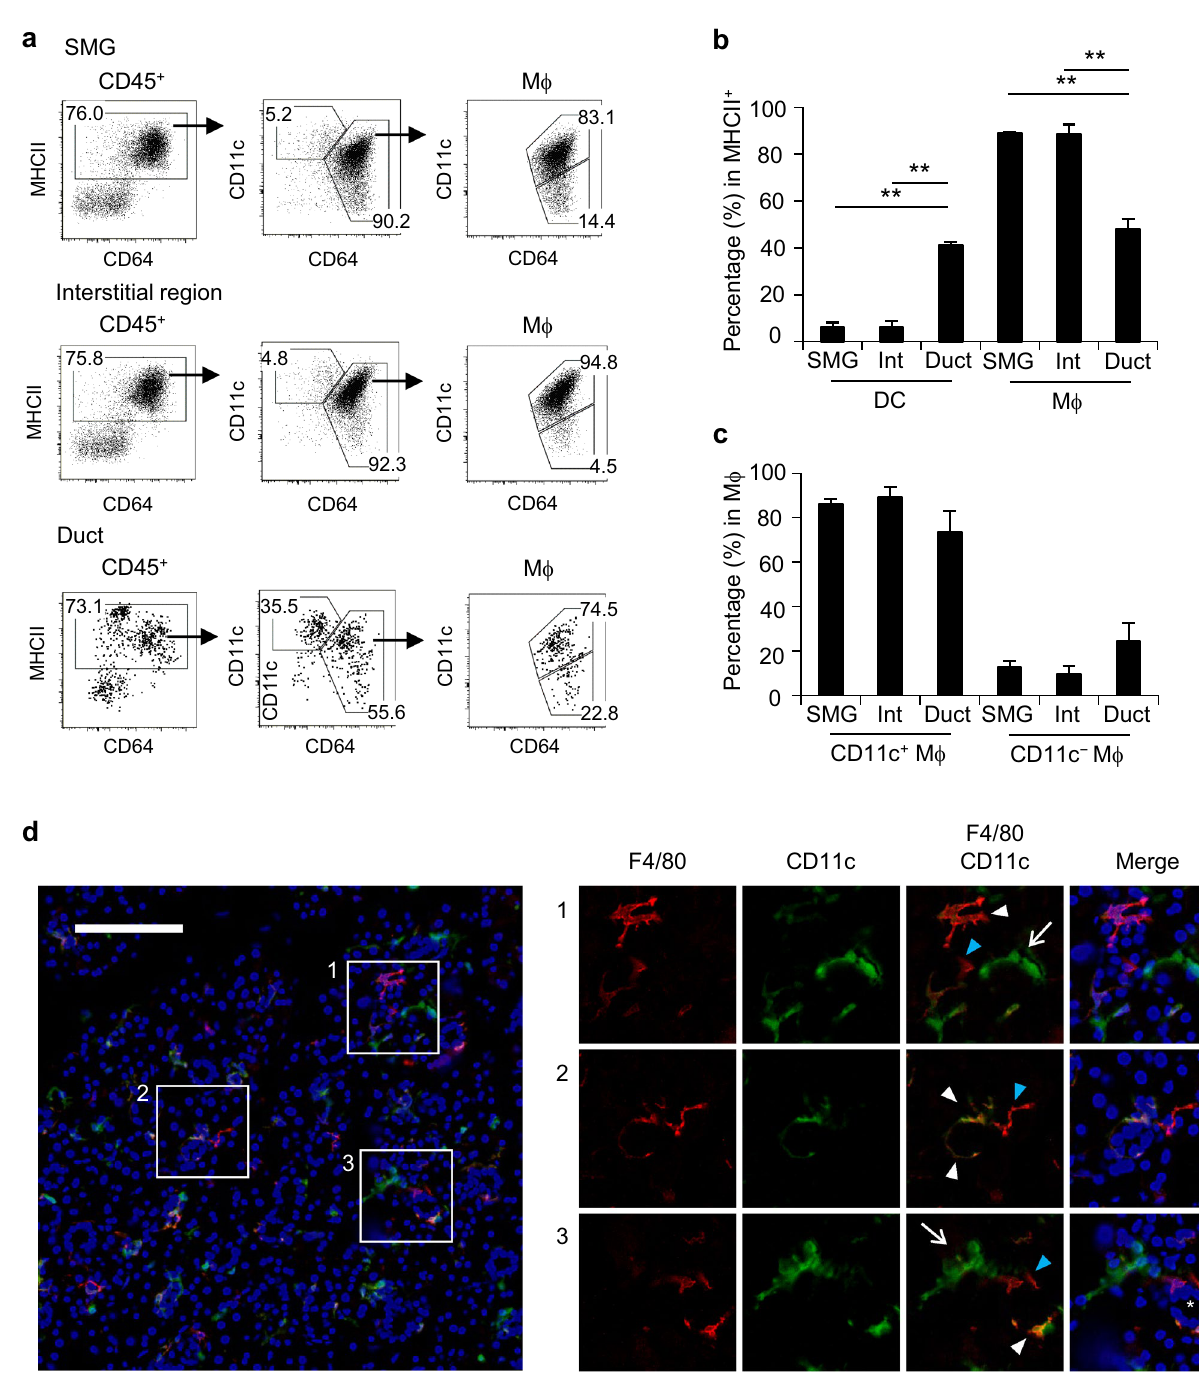
Figure 2. Localization of macrophage subsets in steady-state SGs. Female C57BL/6N mice at 7–12 weeks old were used. ( a – c ) DCs and macrophages in whole SMGs and in the interstitial region and purified ducts of SMGs were analyzed by flow cytometry. Representative FACS plots ( a ), the percentages of DCs and macrophages in MHCII + cells ( b ), and percentages of macrophage subsets ( c ) are shown. Bars represent the mean ± SD ( n = 3). ** P < 0.01 by the Student’s t test with Welch’s correction. ( d ) Sections from SMG were stained with anti-F4/80 (red) and anti-CD11c (green). Images merged with DAPI-counterstained images are shown on the right. Scale bar: 100 μm. White arrowhead: F4/80 + CD11c + . Blue arrowhead: F4/80 + CD11c - . White arrow: F4/80 - CD11c + . *Duct. Data were representative of three individual